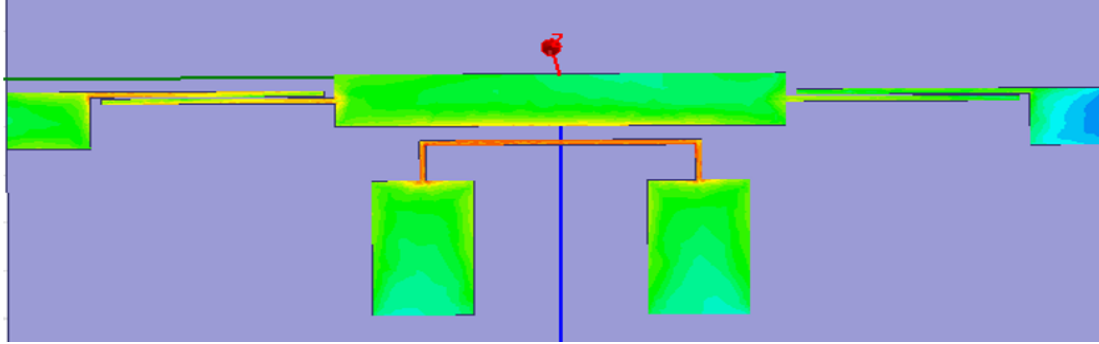
Figure 18. Current distribution of the UWB filter with a notch at 3.5 GHz.